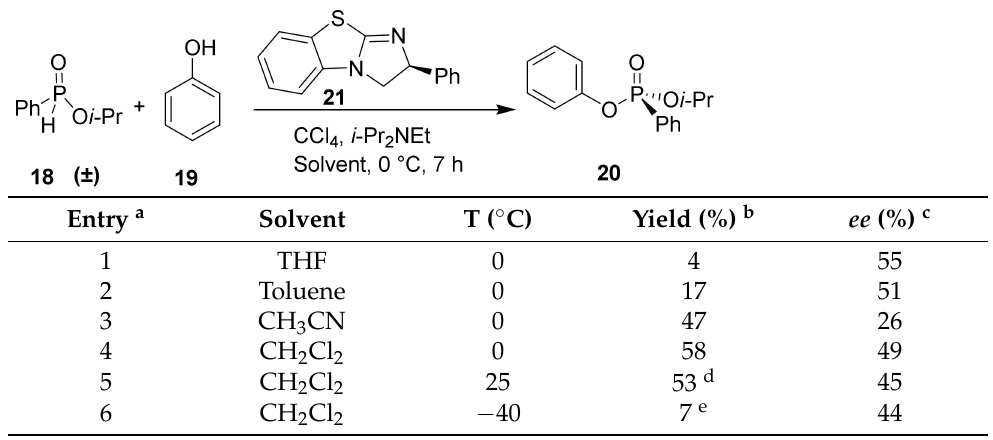
Table 2. The effects of solvent and temperature on the phosphorylation